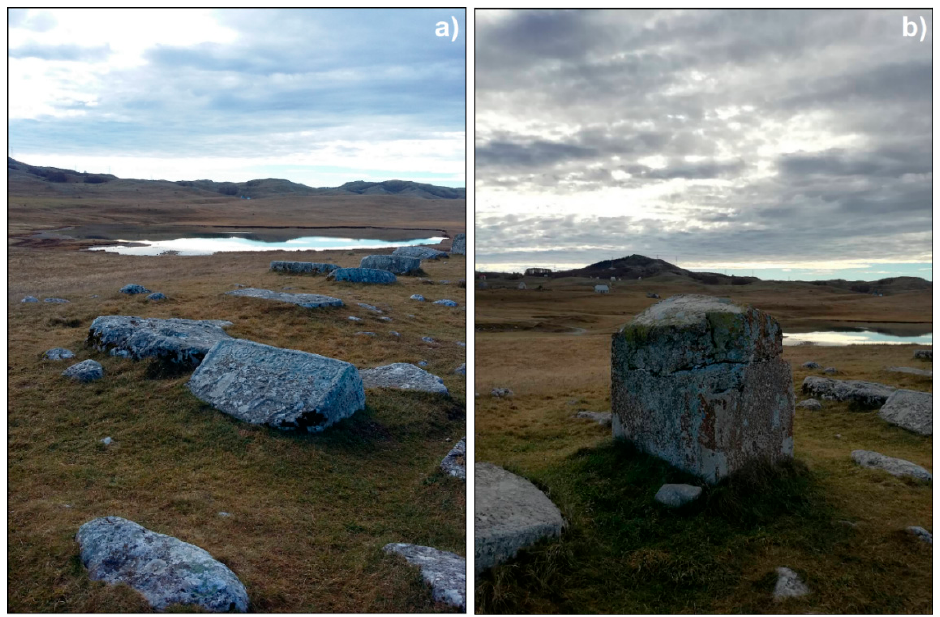
Figure 20. Ste ć ci of Novakovi ć i: view of the necropolis ( a ) and a particular of a tombstone ( b ).